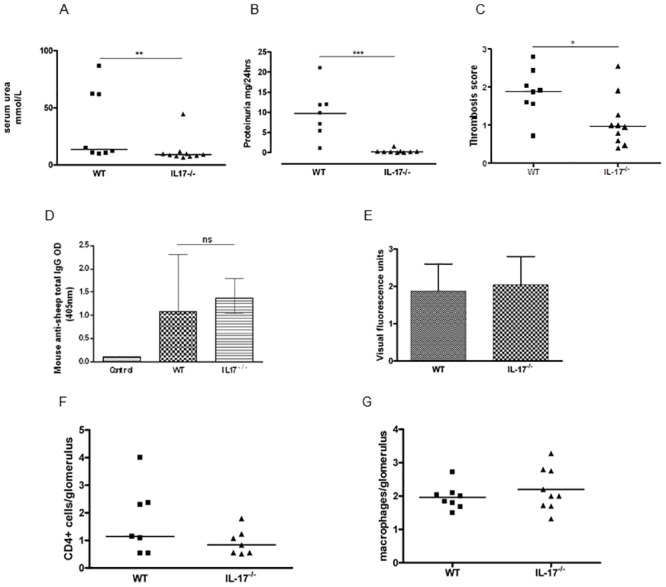
IL-17-/- mice are protected from NTN.IL17-/- mice had significantly (A) lower serum urea (p<0.01), (B) less proteinuria (p<0.001) and (C) less thrombosis (p<0.05) compared to WT mice. There was no difference in humoral responses between the groups either for (D) total serum mouse anti-sheep IgG or (E) glomerular deposition of mouse anti-sheep IgG. There was no significant difference in cellular infiltration of glomeruli by either (F) CD4+ T cells or (G) CD68+ macrophages. Analysis by Two-Way ANOVA and non-parametric Mann-Whitney U test. Bars represent median and range. Lines represent median. * = p<0.05; ** = p<0.01; *** = p<0.001. Differences are non-significant unless otherwise stated. Data shows combined results from 2 experiments of at least 4 mice per group.